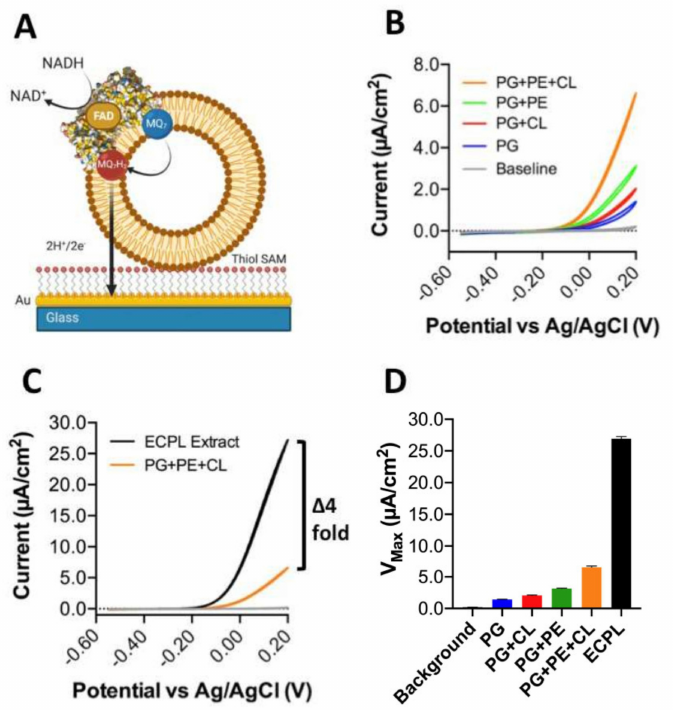
Figure 4. Influence of the lipid composition on efficient Cth NDH-2 catalysis using direct extraction of electrons from membrane-bound menaquione-7. ( A ) Cth NDH-2 was reconstituted into vesicles composed of 1% menaquinone-7 (MQ 7 ) in one of the following lipid compositions: pure phosphatidyl- glycerol (PG; blue); PG + 10% cardiolipin ((CL) red); 33% PG + 67% phosphatidylethanolamine ((PE) green); 9.8% CL + 23.2% PG + 67% PE (orange); and E. coli polar lipid extraction (ECPL; black). Assays were performed using proteoliposomes adhering to an 8-mercaptooctanol self-assembled monolayer on top of a flat gold electrode using the experimental system shown in ( A ). The lipids are displayed in brown, Cth NDH-2 represented as a space-filling model (PDB:6BDO), and the lipid-bound MQ 7 as red/blue. ( B , C ), Cyclic voltammograms of Cth NDH-2 activity in different lipid compositions. All solution-phase assays and cyclic voltammetry measurements (CVs) were conducted in a 20 mM MOPS and 30 mM Na 2 SO 4 buffer (pH 7.4) at 25 ◦ C. CVs used a 10 mV/scan rate. ( D ), V max values derived from the data in ( B , C ). Experiments were performed in triplicate ( B–D ) with representative plots shown and plotted following IUPAC convention ( B , C ), and the error (standard deviation) is shown ( D